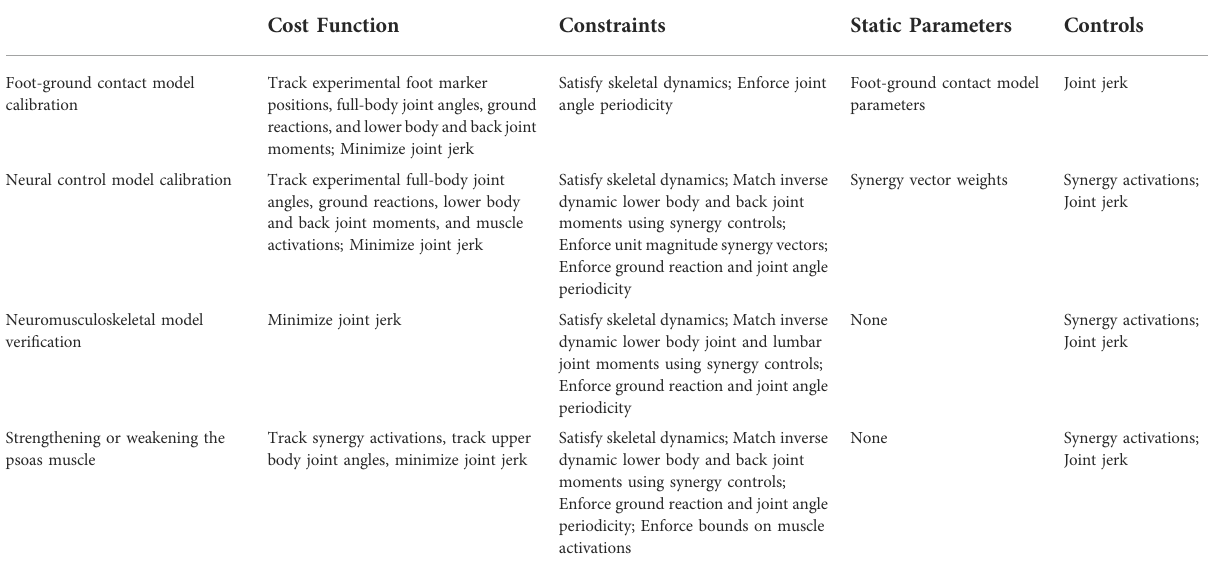
TABLE 2 Overview of direct collocation optimal control problem formulations used for model personalization and treatment optimization. Model